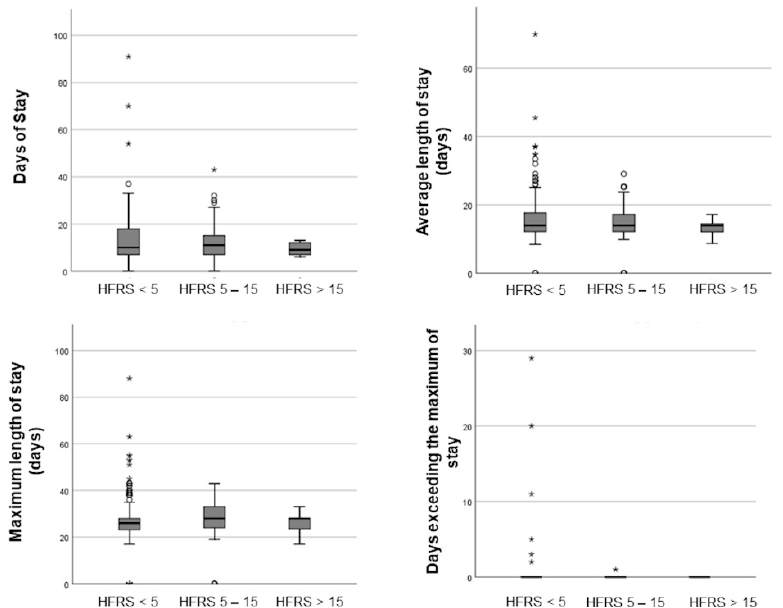
Figure 3. Boxplots of the influence of the HFRS on the length of stay in hospital. A white dot is indicating an outlier (3rd quartile + 1.5 interquartile range or 1st quartile − 1.5 interquartile range) and a * an extreme outlier (3rd quartile + 3 interquartile range or 1st quartile − 3 interquartile range). A similar length of stay is also reflected in the renumeration for the patients.